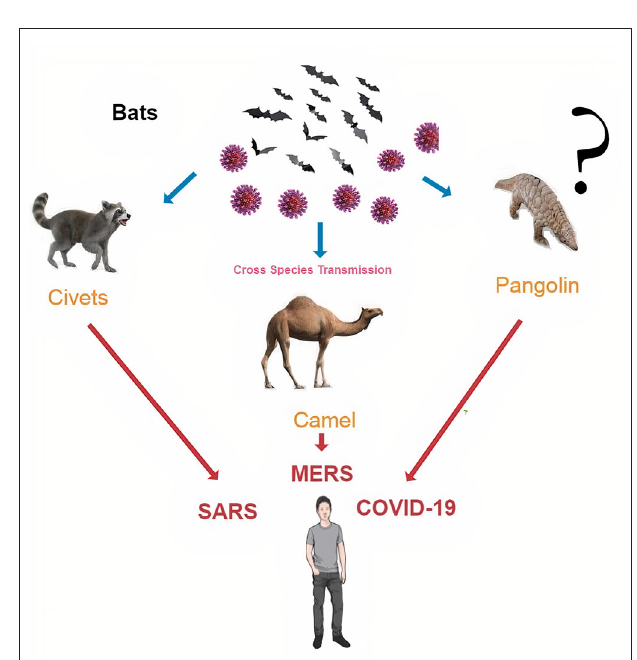
FIGURE 2 | The last three coronavirus pandemics that human populations faced are SARS, Middle East respiratory syndrome (MERS), and COVID-19. They are originated in bats and then transmitted to humans via intermediate hosts, such as civet in SARS, dromedary camel in MERS, and pangolins mostly in